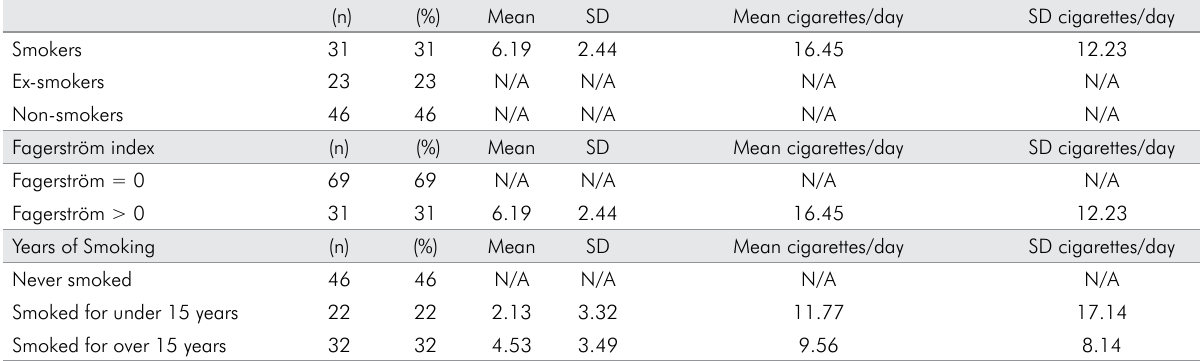
Table 4. Mean nicotine dependence scores (SD) in smokers, ex-smokers and